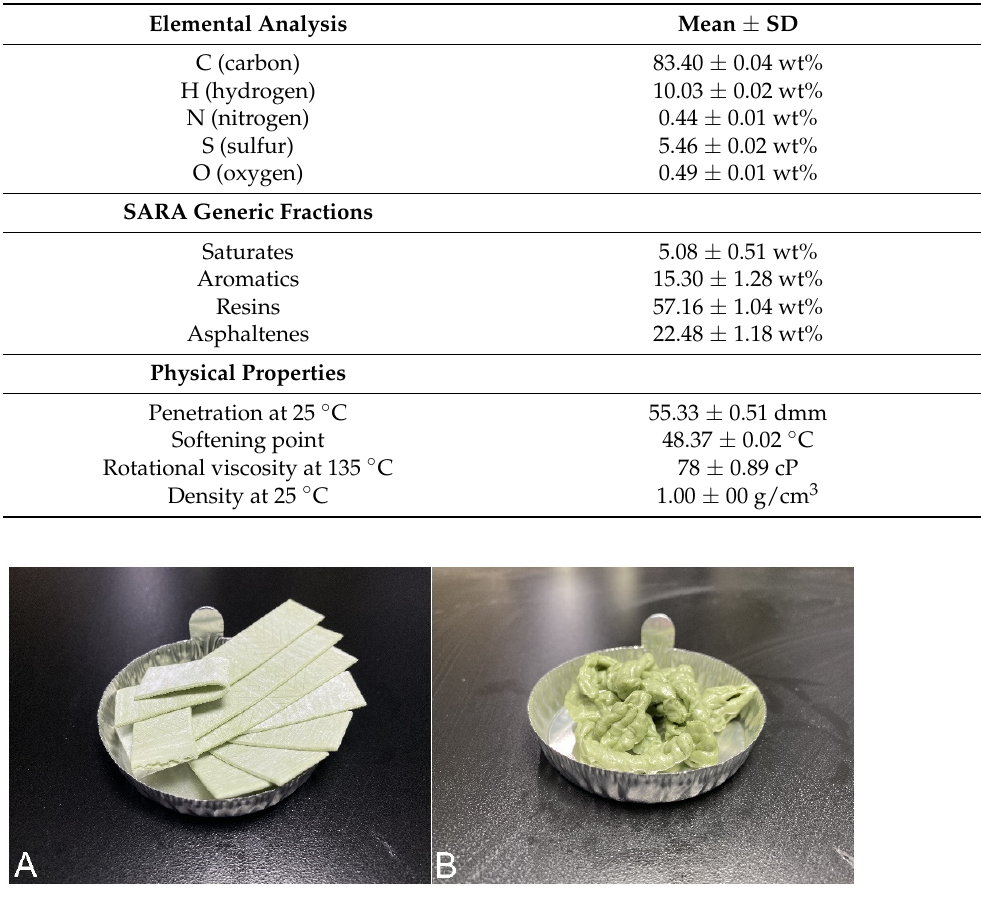
Figure 1. Commercial chewing gum ( A ) and its fresh discarded ( B ) specimens.